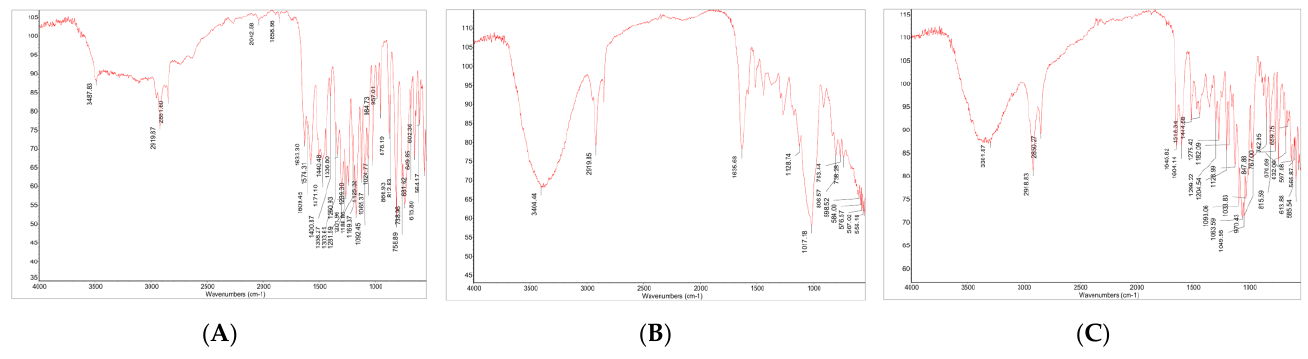
Figure 3. FT-IR spectra of hesperetin, hesperidin and hesperidin glucosides. ( A ) Hesperetin, ( B ) Hesperidin, ( C ) hesperidin glucoside (mono-glucoside).